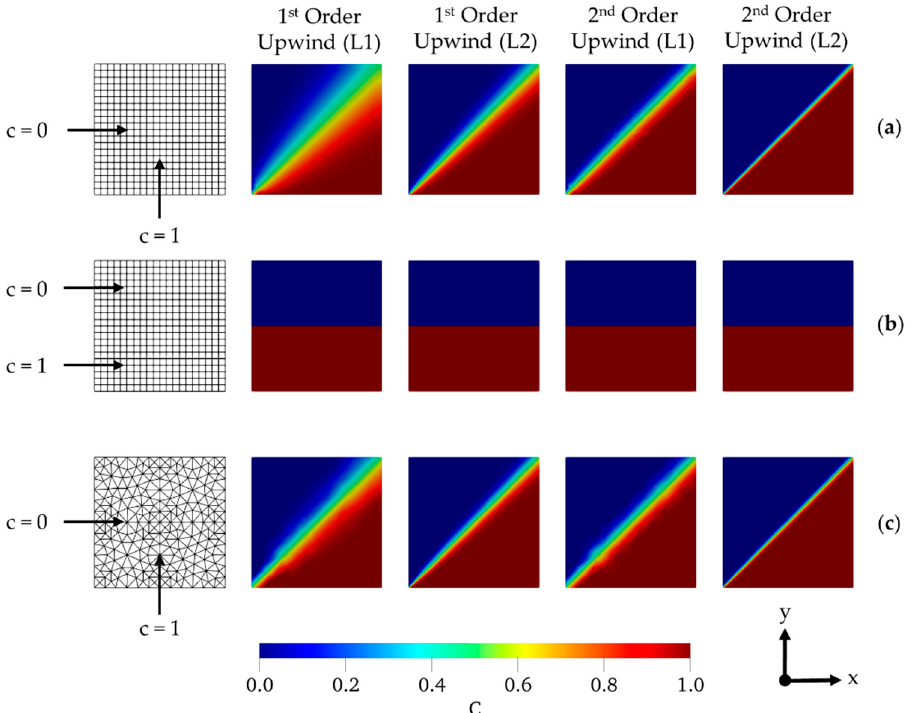
Figure 1. 2-D test case: ( a ) square elements with 45 ◦ flow angle; ( b ) square elements with 90 ◦ flow Figure 1. 2 ‐ D test case: ( a ) square elements with 45° flow angle; ( b ) square elements with 90° flow angle; and ( c ) triangular elements with randomly changing flow-boundary angle angle; and ( c ) triangular elements with randomly changing flow ‐ boundary angle [9].